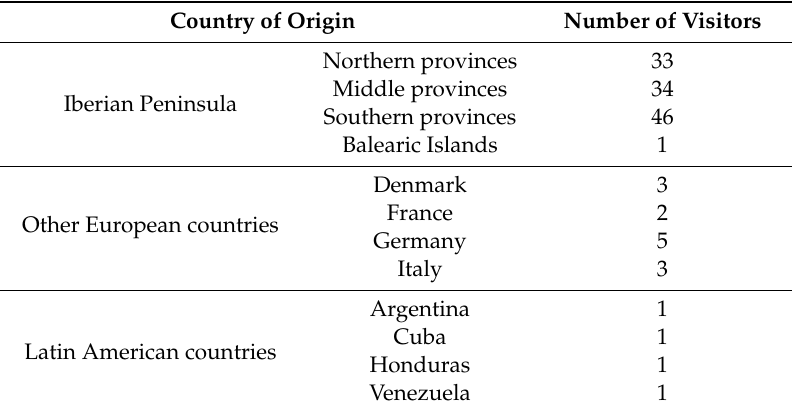
Table 1. Camelback riding customer’s